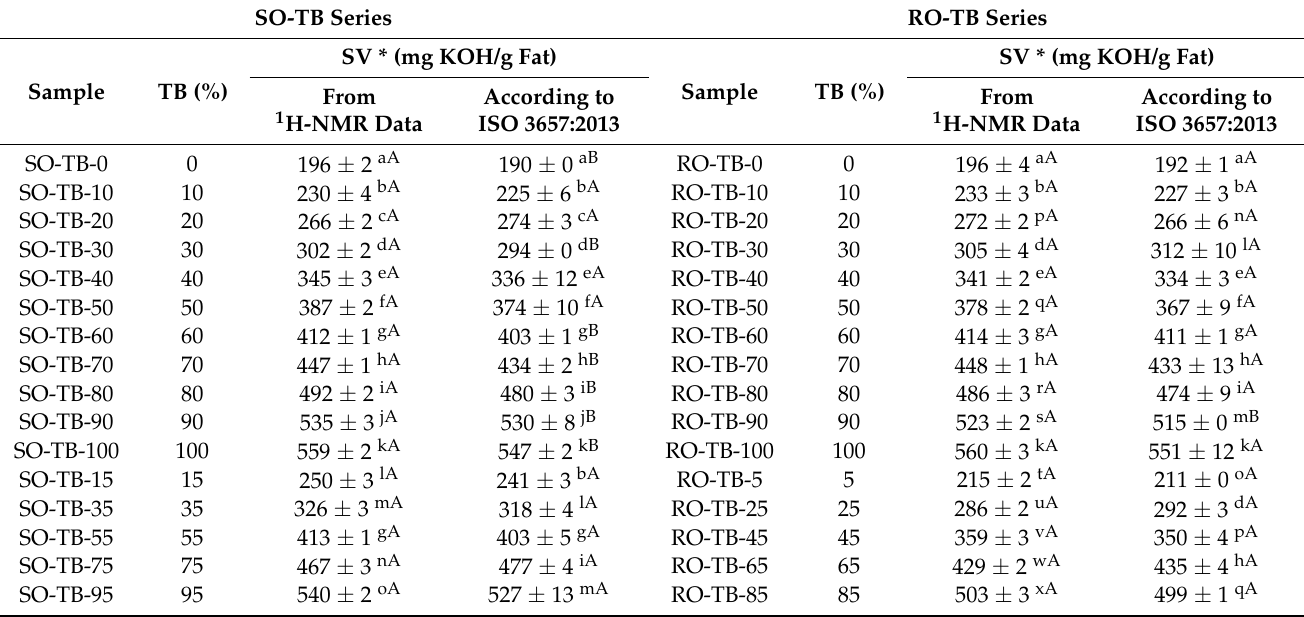
Table 2. SVs determined from the 1 H-NMR data and through the standard (i.e., ISO 3657:2013) method for the SO-TB and RO-TB series (95% confidence